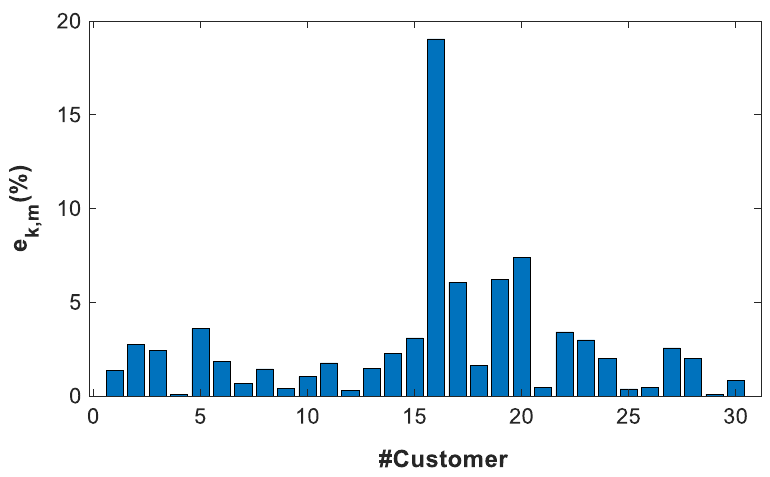
(cid:92) Figure 16. The partial error of the full energies profiles, 𝑌 𝐴𝐵𝐴𝐵,𝑚 ̂ , of cluster k = ABAB with the re- Y ABAB , m , of cluster k = ABAB with the respect Figure 16. The partial error of the full energies profiles, (cid:92) spect to the estimate power profile 𝑌 𝐴𝐵𝐴𝐵 ̂ . The error is normalized by the contractual power of the Y ABAB . The error is normalized by the contractual power of the cluster to the estimate power profile cluster ABAB (P ABAB = 16.5 kW). ABAB (P ABAB = 16.5 kW).